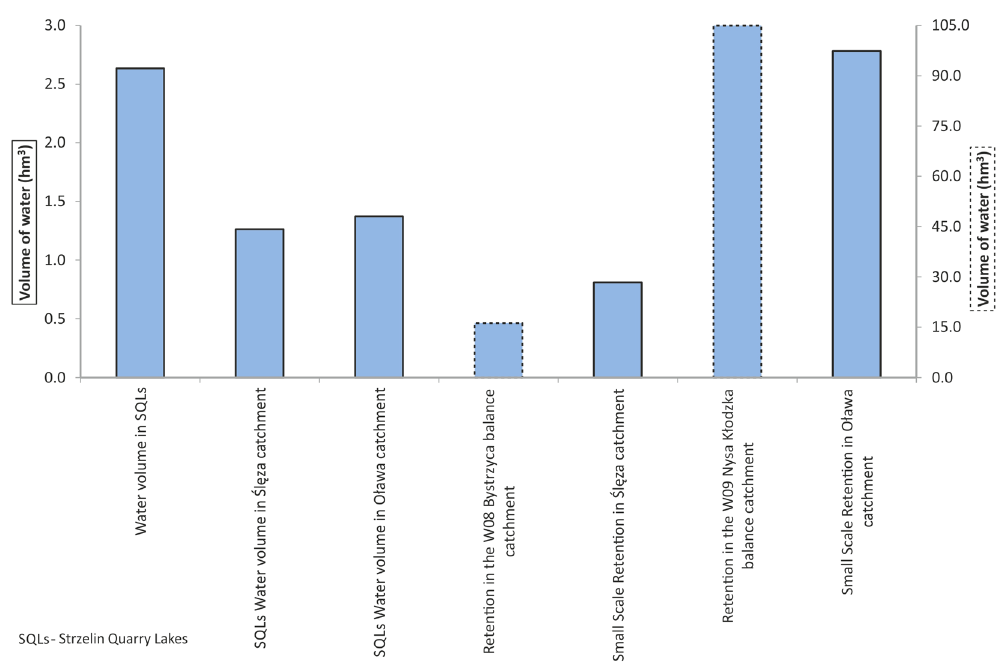
Figure 5. Volume of water retained in small-scale reservoir and pond retention and water retained in Strzelin Quarry Lakes (left scale—the water volume value for columns with solid border lines, right scale—the water volume value for columns with dotted border